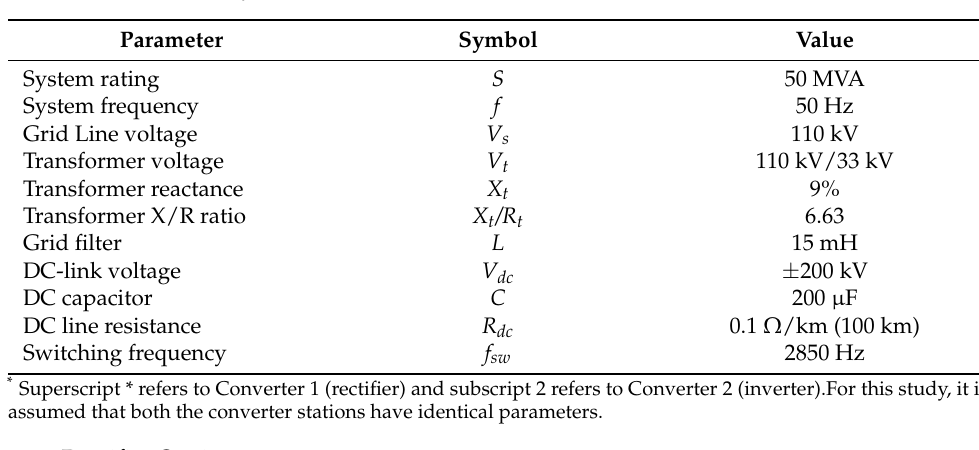
Table 1. * VSC HVDC System